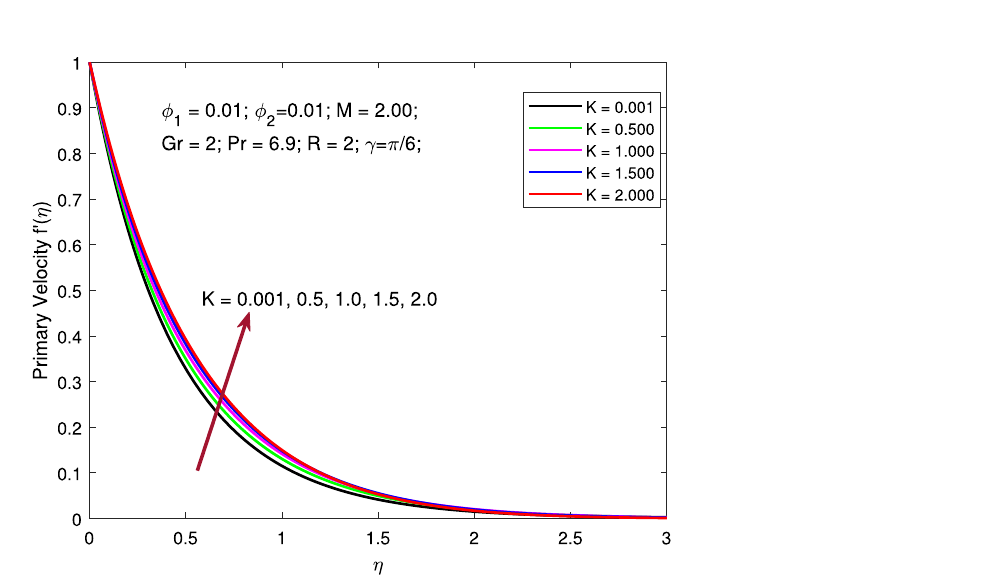
Figure 2. Variation of primary velocity with Coriolis